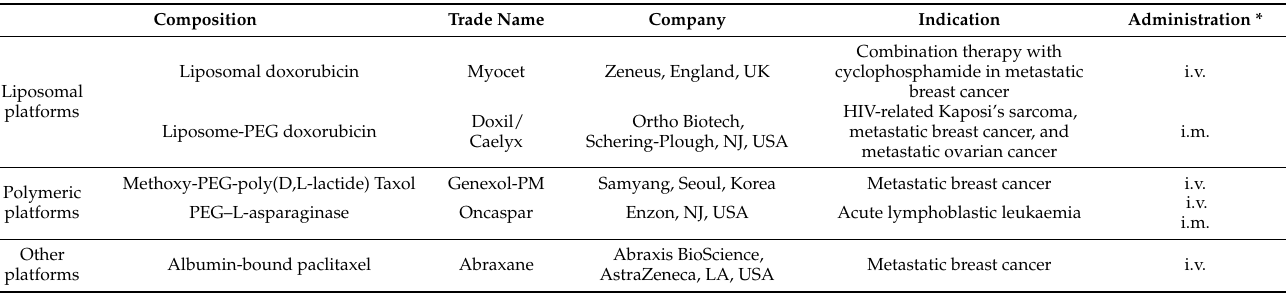
Table 3. Clinically approved nanoparticle-based cancer